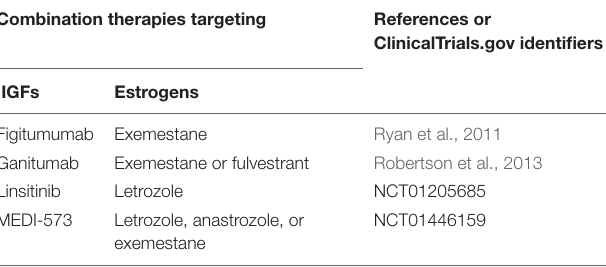
TABLE 3 | Main combination therapies targeting the IIGFs and estrogen signaling. Combination therapies